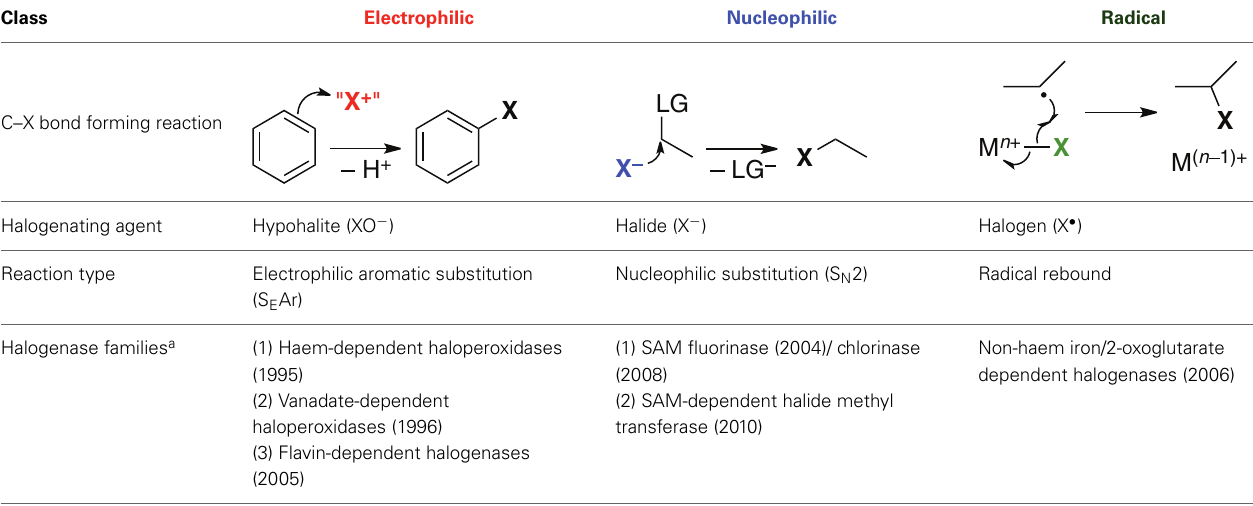
Table 1 | Classes of halogenases according to chemical nature of the halogenating